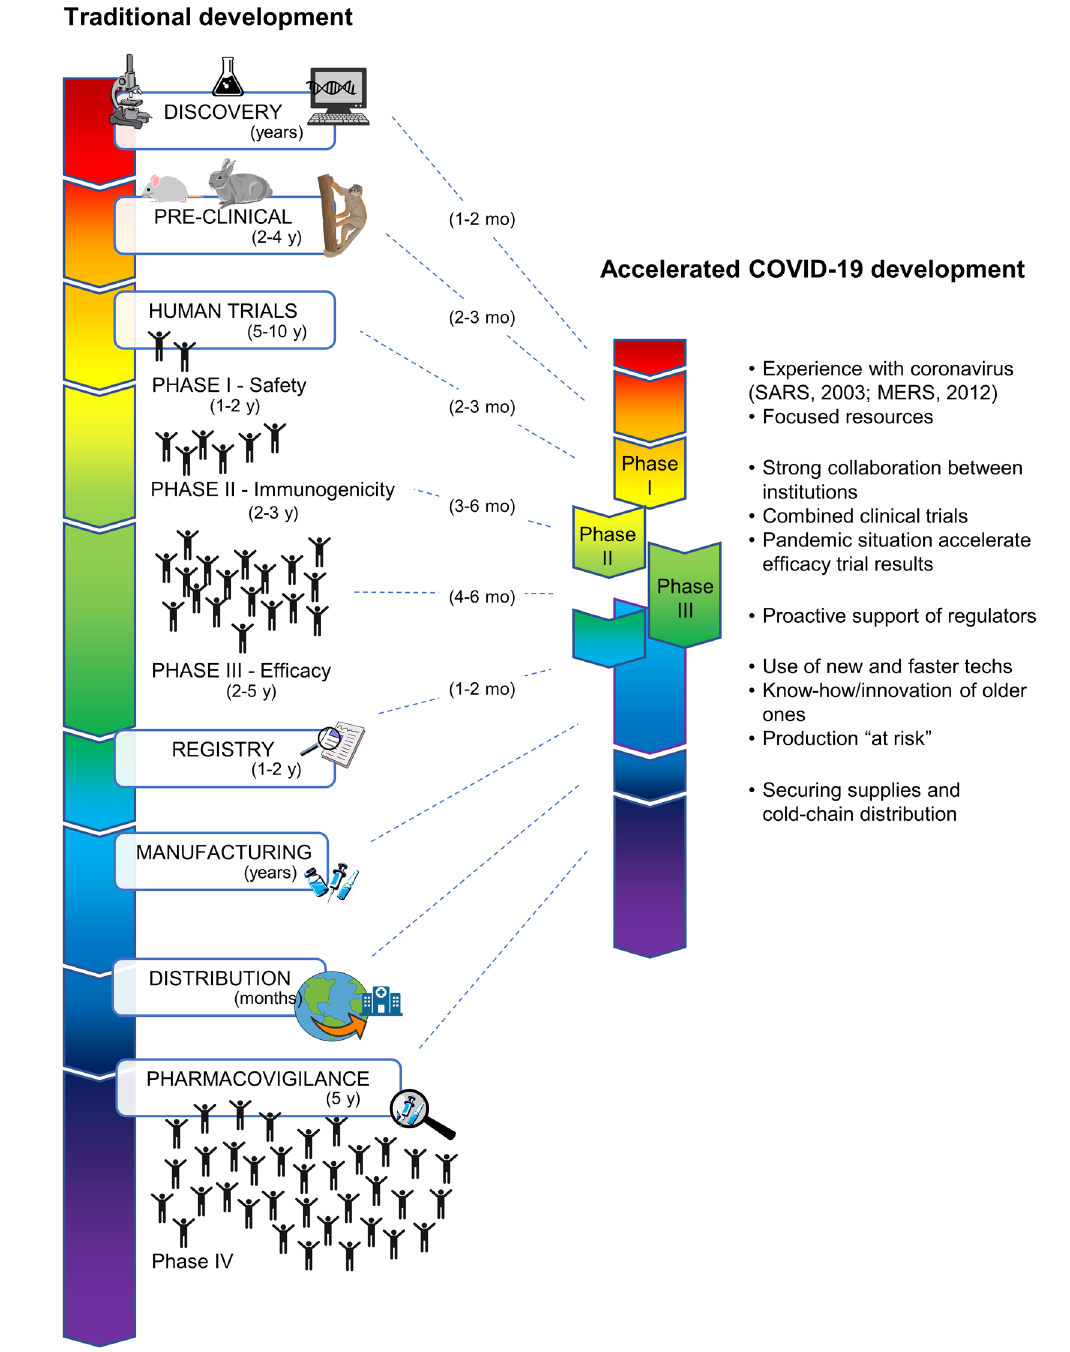
Figure 1 – Traditional and accelerated COVID-19 vaccine development. Illustration of the steps and timeline of traditional vaccine development in comparison to the accelerated COVID-19 scheme. Factors that explain the fast-paced progress for COVID-19 are presented.